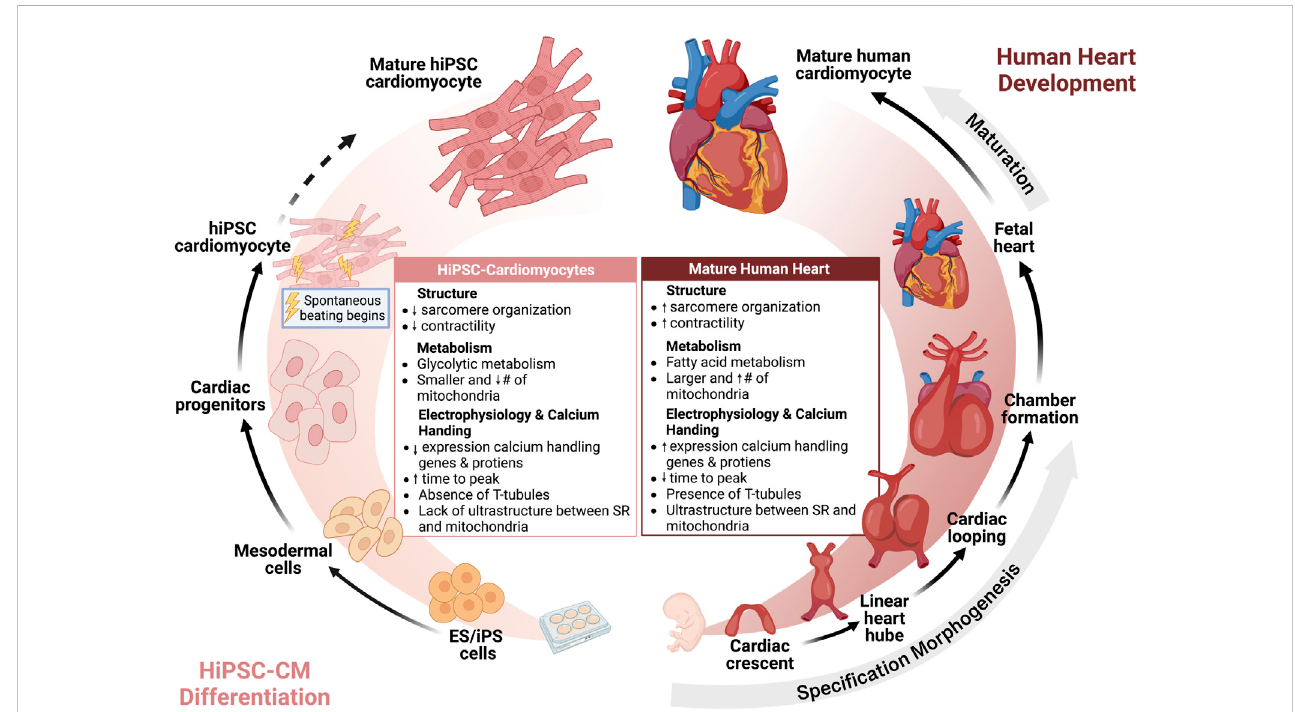
FIGURE 2 Human induced pluripotent stem cell cardiomyocytes are immature but re fl ect human heart development. Insights from cardiac morphogenesis has facilitated differentiation of hiPSC to hiPSC-CMs. Currently, hiPSC-CMs are immature compared to adult human cardiomyocytes, but further strategies for maturation may advance the maturity of hiPSC-CMs towards an adult